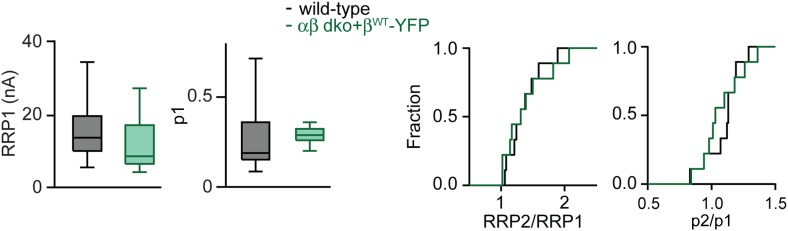
Determining the contributions of RRP and p in wild-type and rescued PTP at the functionally mature calyx of Held.Synaptic mechanisms of PTP were examined using stimulus trains in the presence of kynurenate and CTZ. Left, box-plots of basal RRP size (RRP1; left) and basal p (p1; right), estimated from the 1st AP train for wild-type group (black) and αβ dko group expressing βWT-YFP (green). Medians and interquartile ranges (Q3-Q1) are shown. Whiskers extend to max and min values for each group. Box-plots were used to illustrate the full data range of each group. Right, cumulative histograms of changes in RRP (RRP2/RRP1) and p (p2/p1) with PTP.